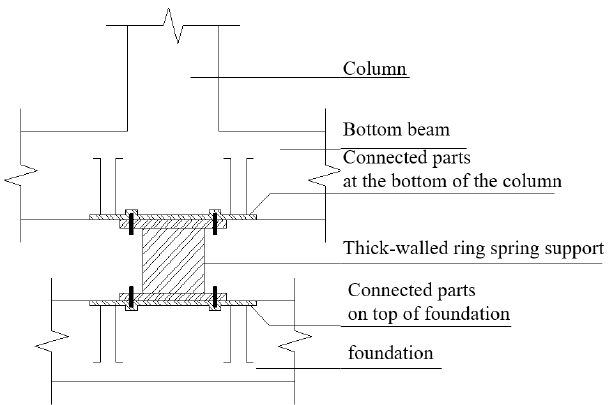
Figure 14. Vertical section schematic diagram of the vibration isolation connection at the column bottom.